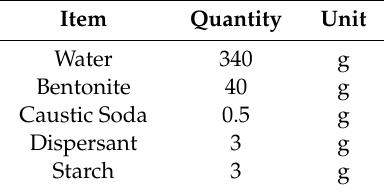
Table 2. HBM formulation prepared in the laboratory for the experimental investigation. Item Quantity Unit